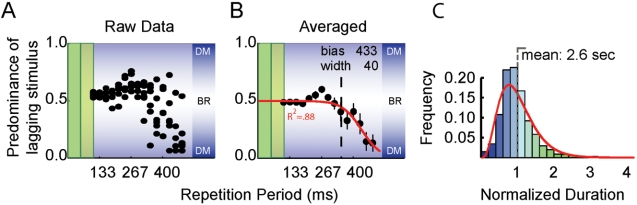
The independence of rapid interocular inhibition (Experiment 2).The temporal limit identified in Experiment 1 is largely uninfluenced by asymmetric stimulation between the eyes, and therefore independent of rapid inter-ocular inhibition. This subject's data show an unbiased perception for periods up to about 433 ms; only for greater periods inter-ocular inhibition causes perceptual biases. A. Data for single trials. B. Means (± s.e.m.). The vertical dashed line represents the position of the temporal limit found in Experiment 1. The small excursion towards unity near a period of 267 ms did not occur for other observers. Averaged over 4 subjects, the temporal limit is 348±33 ms (mean±between-subject s.e.). C. The dominance duration distribution for the conditions with repetition periods of 213–267 ms. Even though the patterns in the two eyes are not delivered simultaneously, a gamma distribution characteristic of binocular rivalry is obtained. Normalized dominance durations were obtained by dividing percept durations by the average percept duration for each subject individually. Gamma fit parameters: shape: 4.2; scale: 0.24. The non-normalized mean percept durations are also similar to durations for conventional binocular rivalry: 2.6±0.5 seconds (mean±s.e.m over subjects). BR = Binocular rivalry; DM = Dichoptic Masking (i.e. very biased rivalry), note that at long repetition periods the stimulus is indeed very much like a series of rapidly paced dichoptic masking trials.